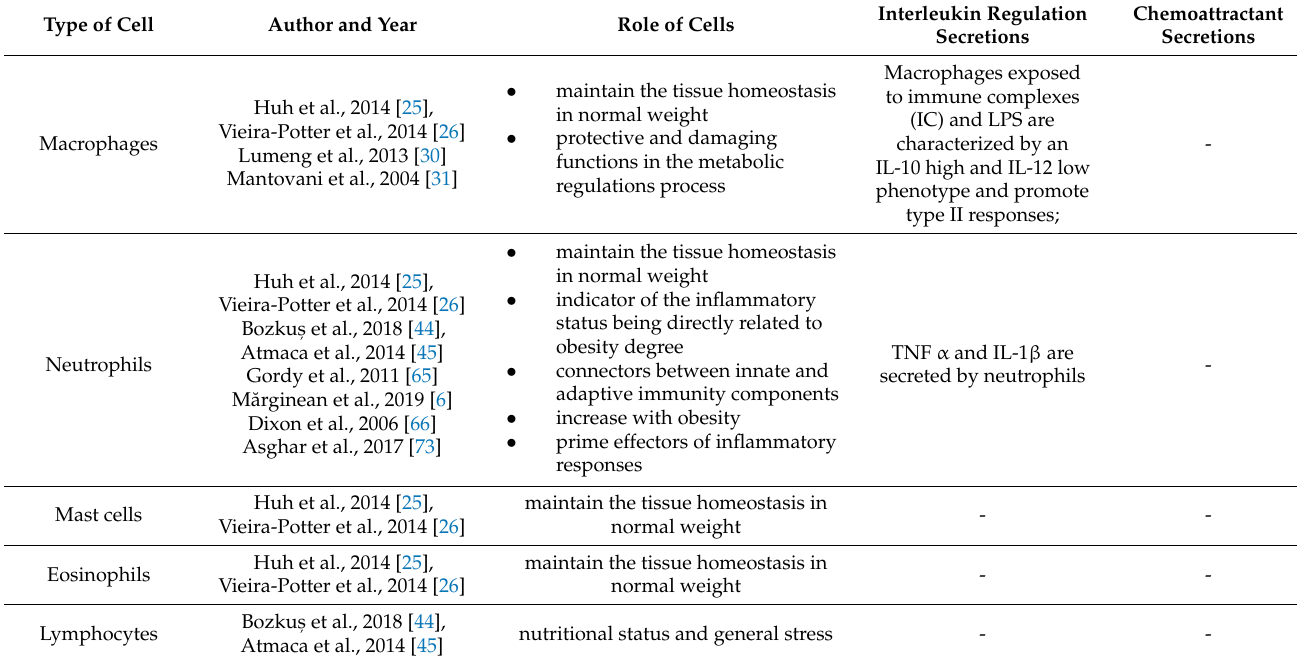
Table 1. The role of different types of cells involved in regulations of the bridge among obesity, immunity, and systemic